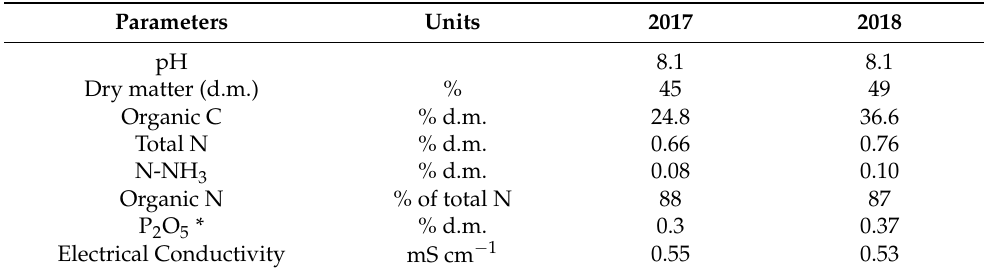
Table 2. Main chemical characteristics of digestates utilized in the two years of the experiment.